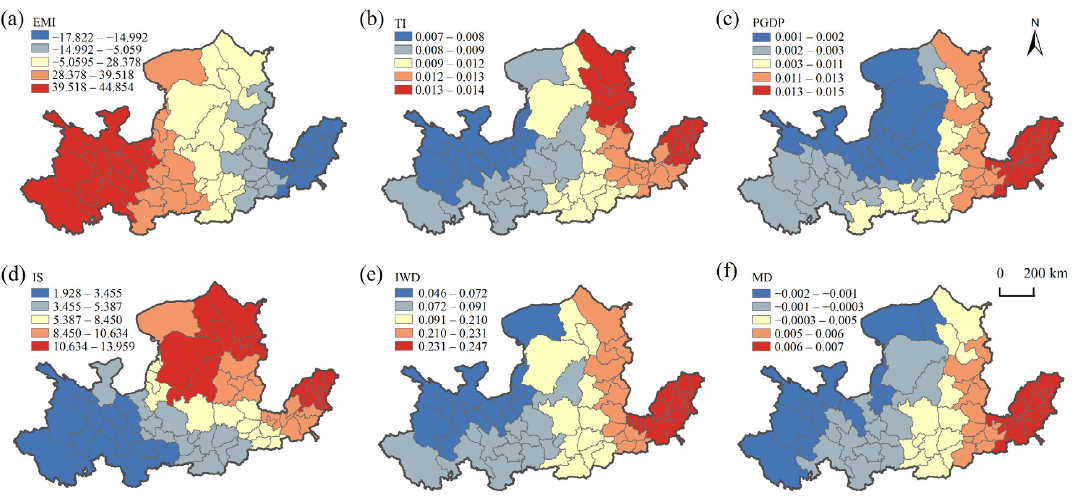
Figure 6. Spatial distribution of regression coefficients of GWR model. ( a ) Natural resource endow- ment; ( b ) technological innovation; ( c ) economic development level; ( d ) industrial structure; ( e ) in- dustrial wastewater discharge scale; ( f ) minimum distance of WPIIs to rivers.